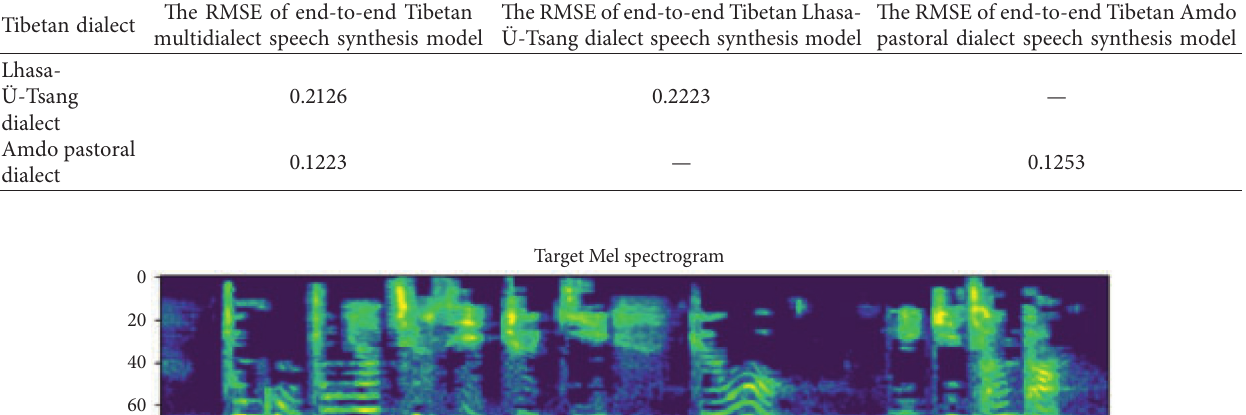
Table 1: Objective evaluation of the results.